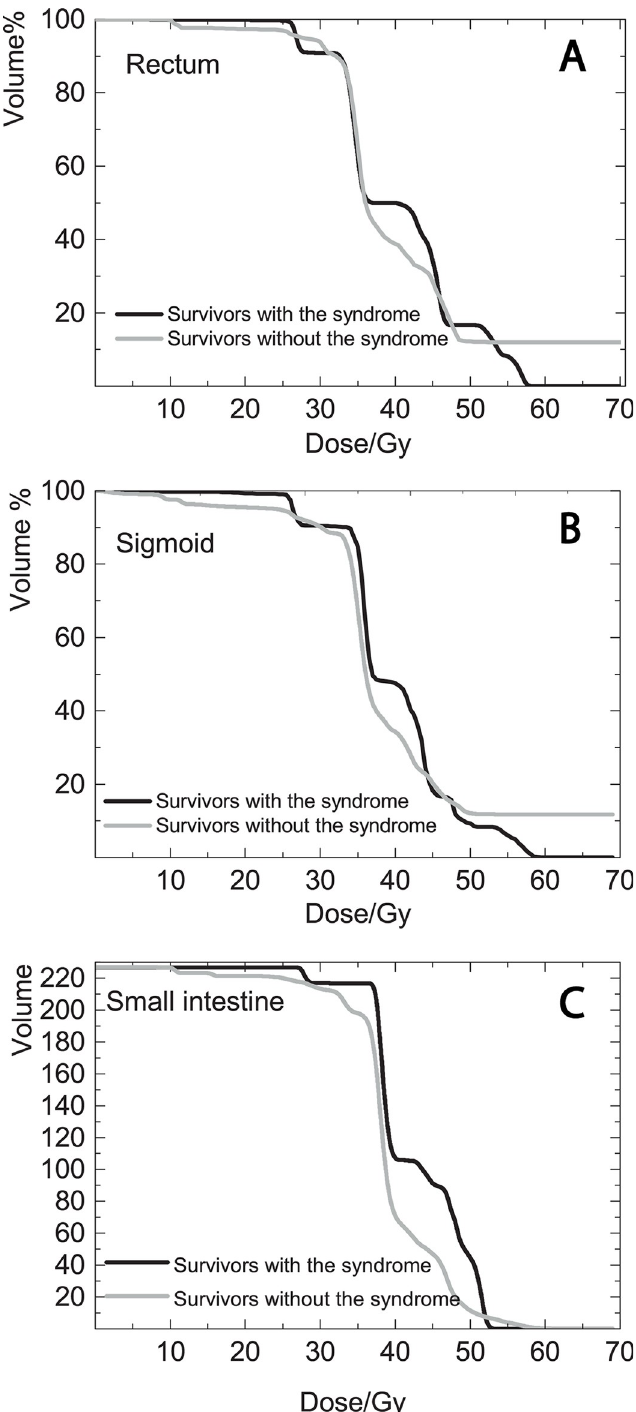
Fig 2. Dose-volume histograms for the survivors with and without ‘excessive mucus discharge’. Mean cumulative DVHs of rectum, sigmoid colon and small intestines for survivors with (black line) and without (grey line) ‘excessive mucus